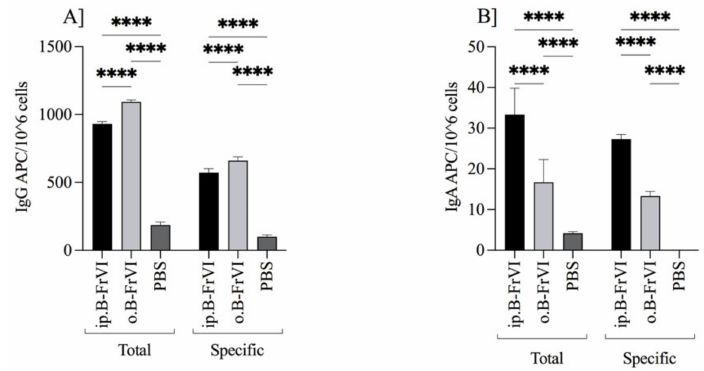
Figure 5. The ( A ) IgG and ( B ) IgA APC responses by Balb/c mice intraperitoneally (ip.B-FrVI) or orally (o.B-FrVI) sensitized with barley fraction VI, and by the control PBS-treated group (PBS). Splenocytes were isolated at the end of experiment from each group (n = 6) and set for B-cell ELISpot assay. The bars represent the mean of the group (n = 6) ± SD. Two-way ANOVA performed the statistical analysis. Statistical differences were assigned **** for p < 0.001.